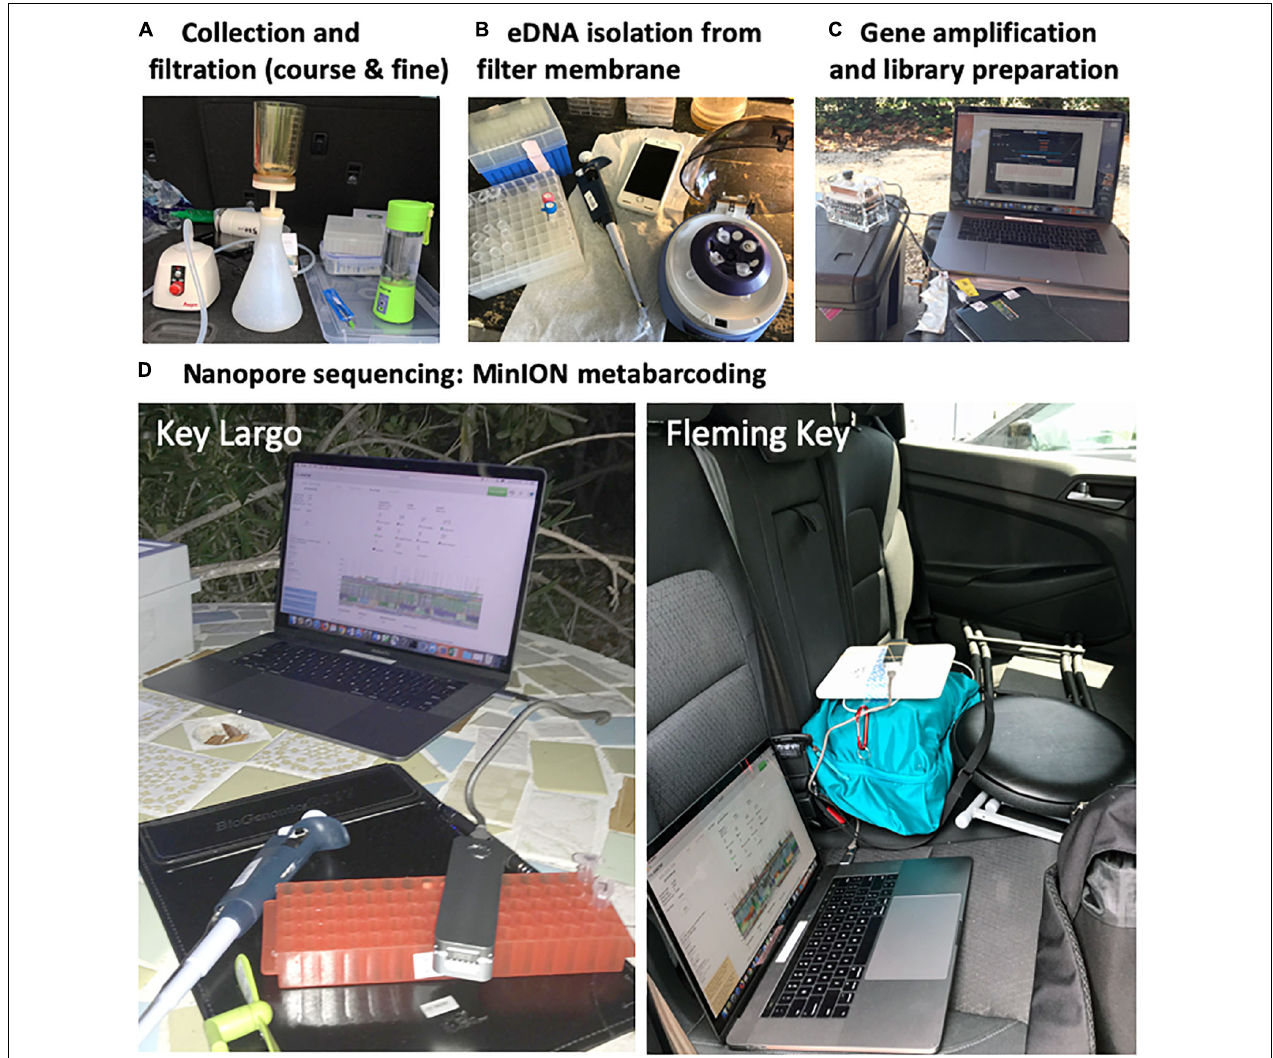
FIGURE 2 | Overview of FeDS workflow used in this study for collection sites in both Upper Keys (BC01 – BC04) and Lower Keys (BC05 – BC08). (A) Triplicate seawater samples were collected from each sampling location and processed in the field within 1–2 h post-collection. Coarse filtration was conducted, followed by homogenization and fine filtration on a water-testing membrane filter. (B) Filter membranes (containing eDNA filtrate) were kept in buffer at ambient temperature until eDNA was extracted; in the final step, isolated eDNA was concentrated in 70 µ l of elution buffer. All equipment was sanitized between stations. (C) Molecular protocols including PCR were carried out using an USB-operated 8-well thermocycler (miniPCR). (D) Nanopore sequencing metabarcoding with MinION commenced in Upper Keys (BC01 – BC04) outside on a bluff overlooking BC03, and in Key West (BC05 – BC08) in a rental